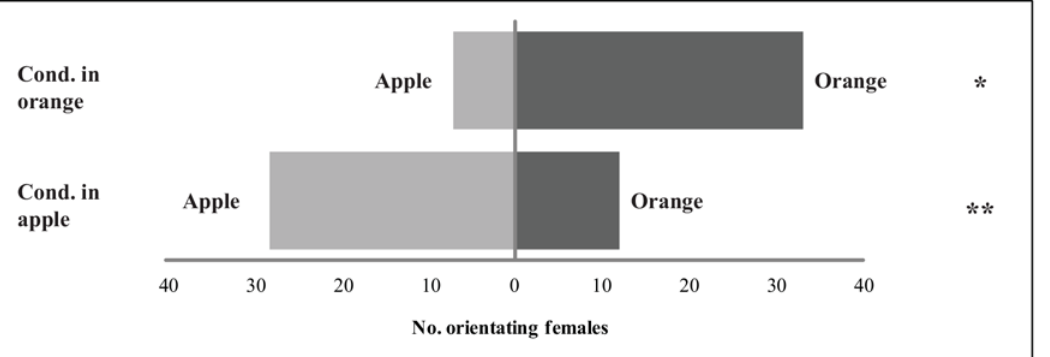
Fig 3. Effect of previous experience on the preference of Diachasmimorpha longicaudata females for different fruit species. Bars show the number of females (conditioned either on apple or orange) visiting each option in the experiment 3. G-test level of significance: * p < 0.05; ** p <